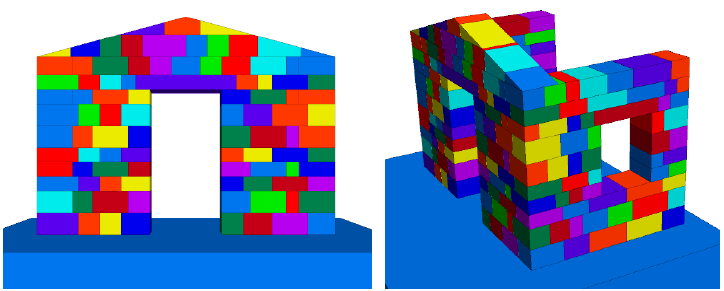
Figure 7. Stone structure: ( a ) general view and ( b ) return wall with opening; ( c ) damage of the return wall after the test (adapted from [23]). Figure 8. Simplified 3DEC model of the stone structure.